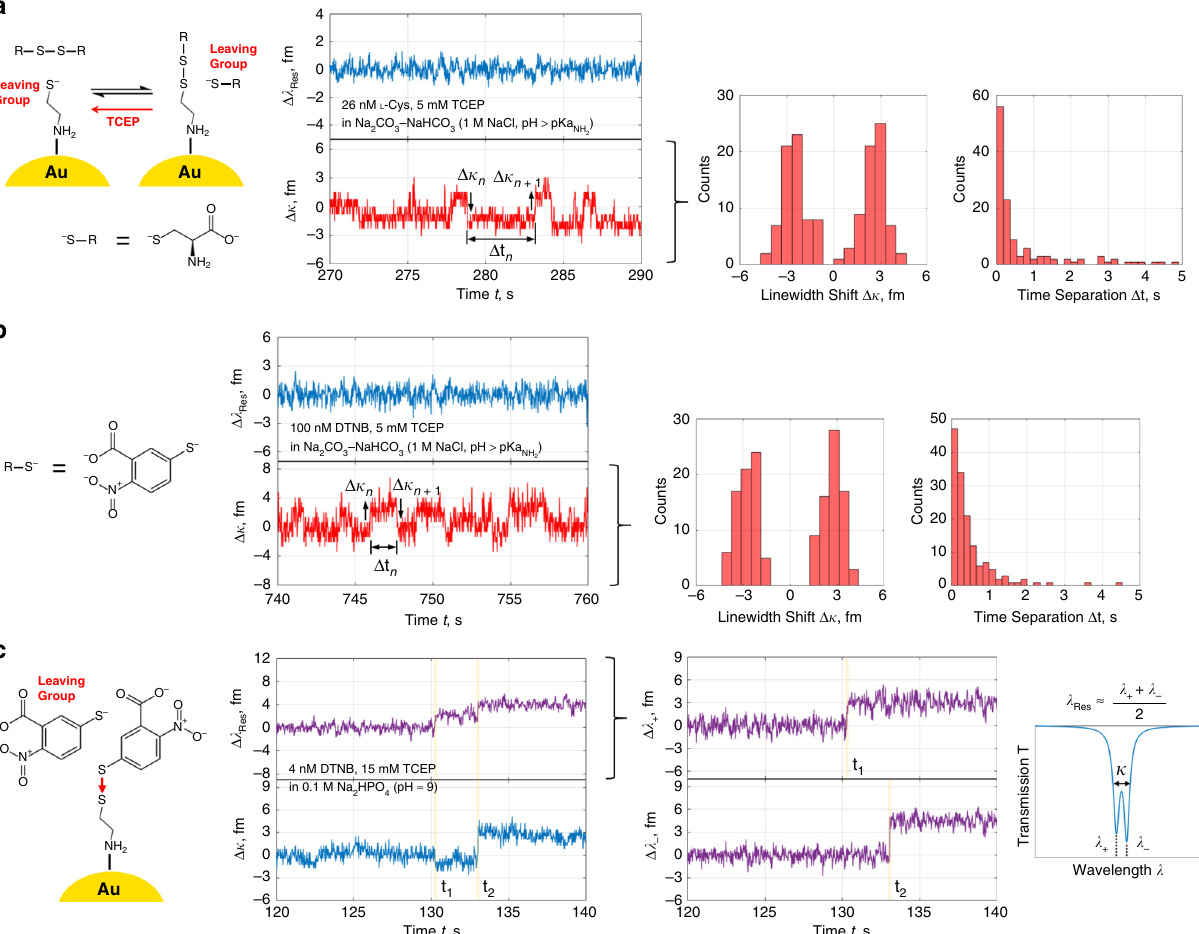
Fig. 5 Cyclical binding/unbinding and exchange interactions with single mixed disul fi des. a Real-time linewidth step oscillations in the LSP-WGM resonance trace from redox reactions involving individual cysteamine- L -cysteine disul fi des at pH > pKa . These bridges are formed between cysteamine NH 2 linkers and L -cysteine thiolates/disul fi des (with neutral amines), then promptly cleaved by excess TCEP. b Linewidth patterns similar to a from individual cysteamine-TNB disul fi des. Thiol-disul fi de exchange may be triggered by DTNB dimers alone; however, cycling is ensured through reduction with TCEP. TNB has a benzene ring with carboxyl, thiol, and nitro groups. c Apparent resonant wavelength and linewidth signal steps, from thiol-disul fi de exchange with DTNB and bound cysteamine, in a resolvable LSP-WGM doublet/split